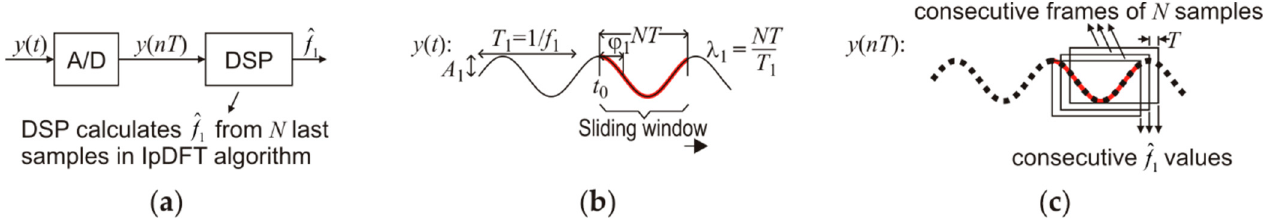
Figure 12. Determination of the frequency estimate f 1 with IpDFT method at every signal sample based on consecutive data frames: ( a ) estimation of f 1 based on (11) and (12) in the DSP system; ( b ) sliding window and phase definition φ 1 of the fundamental component relative to the origin point t 0 of the window; ( c ) updating of the estimate f 1 every sampling period T for successive data frames.